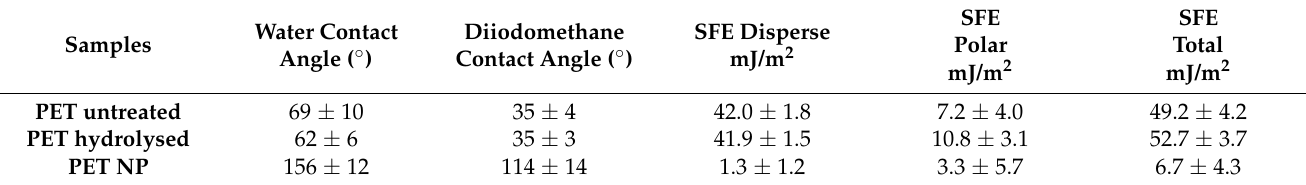
Table 1. Contact angle values determined with water and diiodomethane, and surface free energy (SFE) of PET untreated, PET Hydrolysed and PET NP.